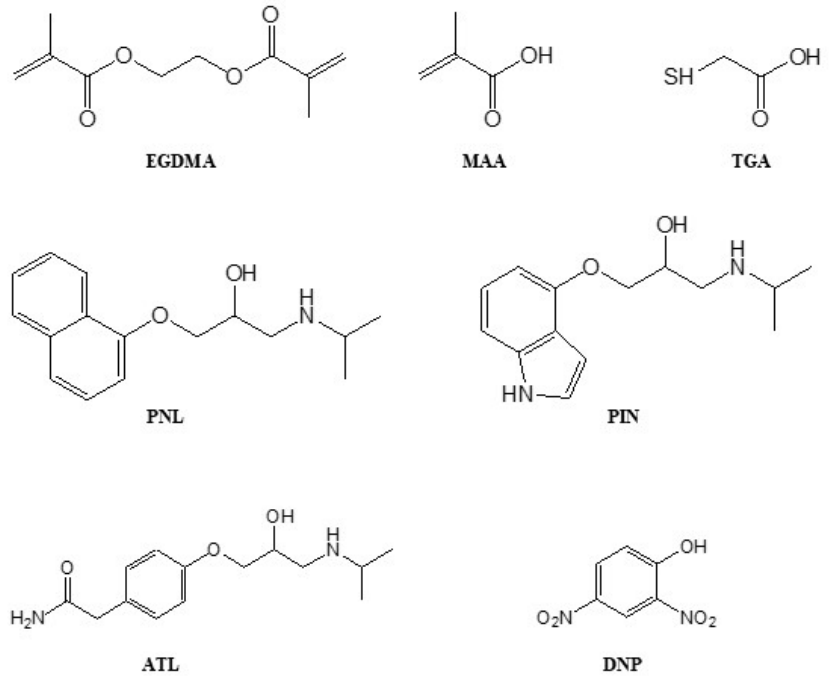
Figure 7. Chemical structures of reagents used for this study.